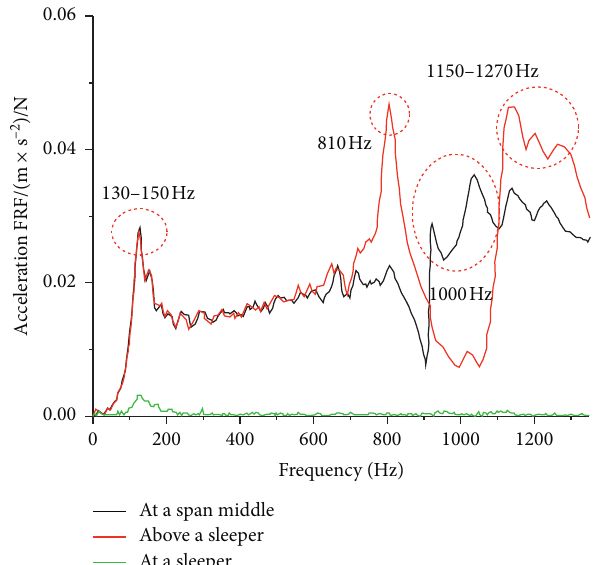
Figure 18: Vertical acceleration transfer functions when a vertical excitation is applied to the track segment above the sleeper.